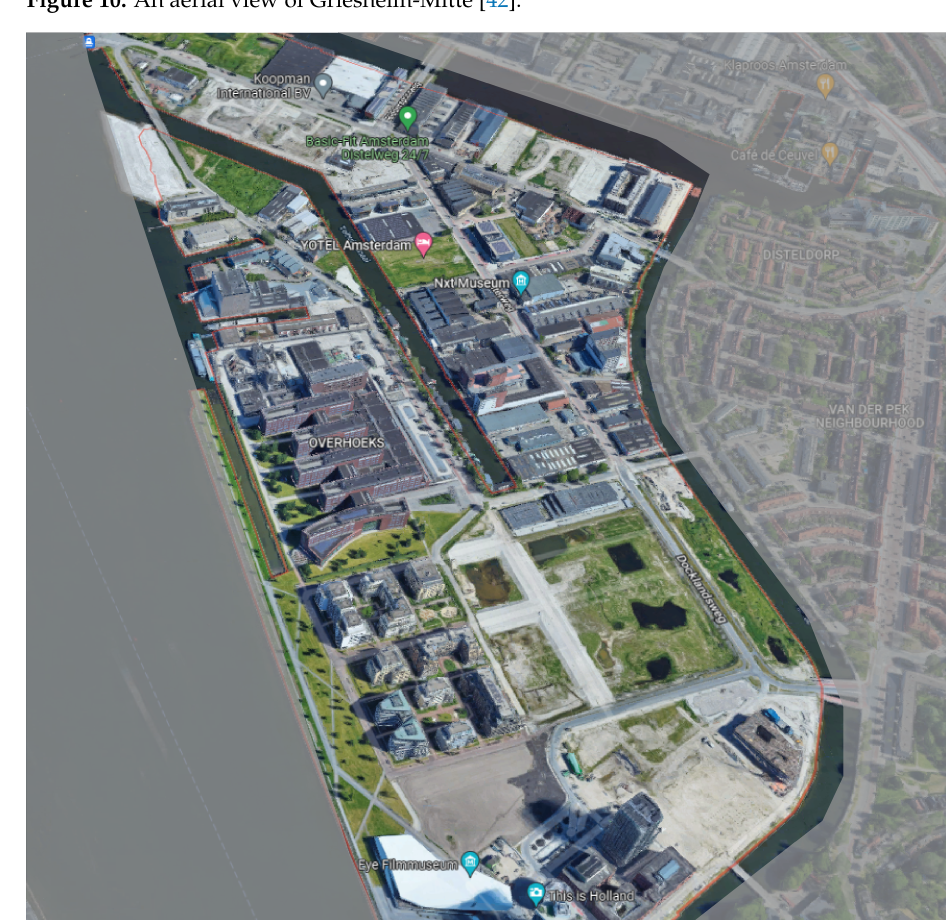
Figure 11. An aerial view of southern Buiksloterham